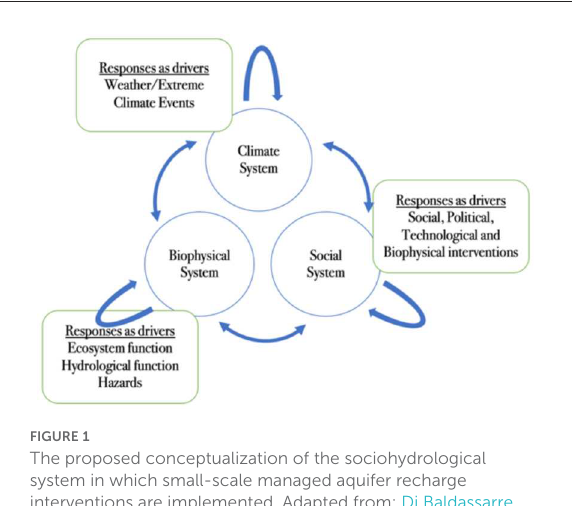
FIGURE1 The proposed conceptualization of the sociohydrological system in which small-scale managed aquifer recharge interventions are implemented. Adapted from: Di Baldassarre et al. (2013), Di Baldassarre et al. (2018), Rusca and Di Baldassarre (2019), and Basel et al. (2020b).